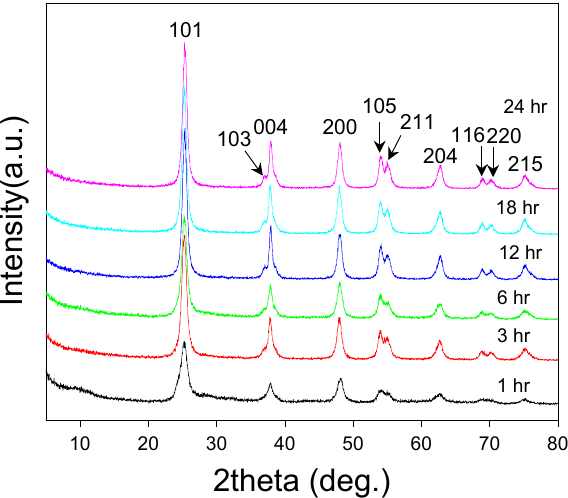
Figure 2. Powder XRD patterns of the samples obtained after post-hydrothermal heat treatment of nanotubes at 120 °C for different time periods.